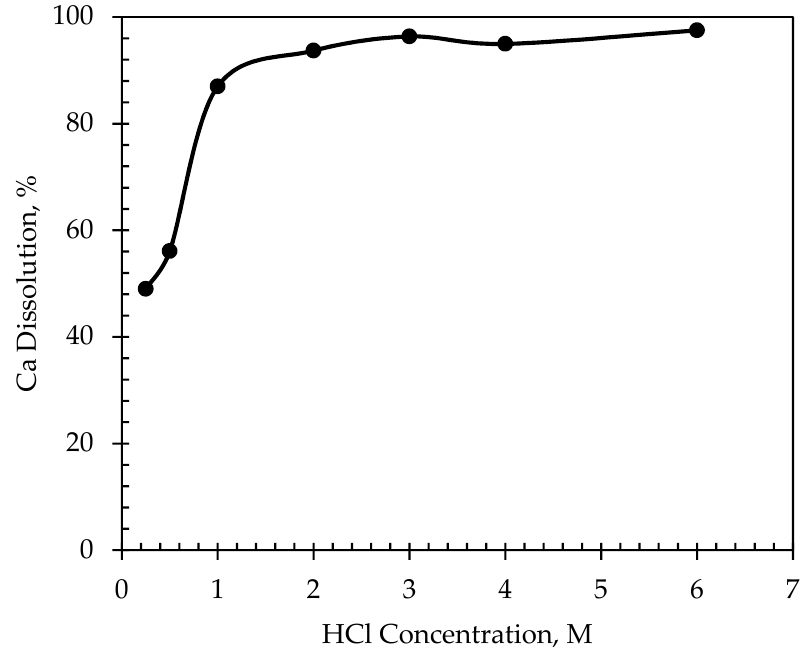
Figure 8. Calcium dissolution curve as a function of acid concentration.